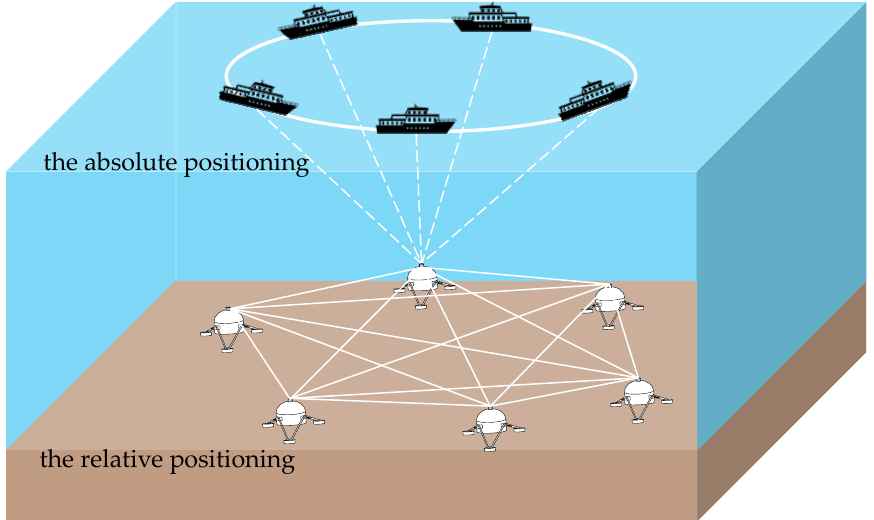
Figure 2. The principle of determining the coordinates of control points in the seafloor PNT net- work.